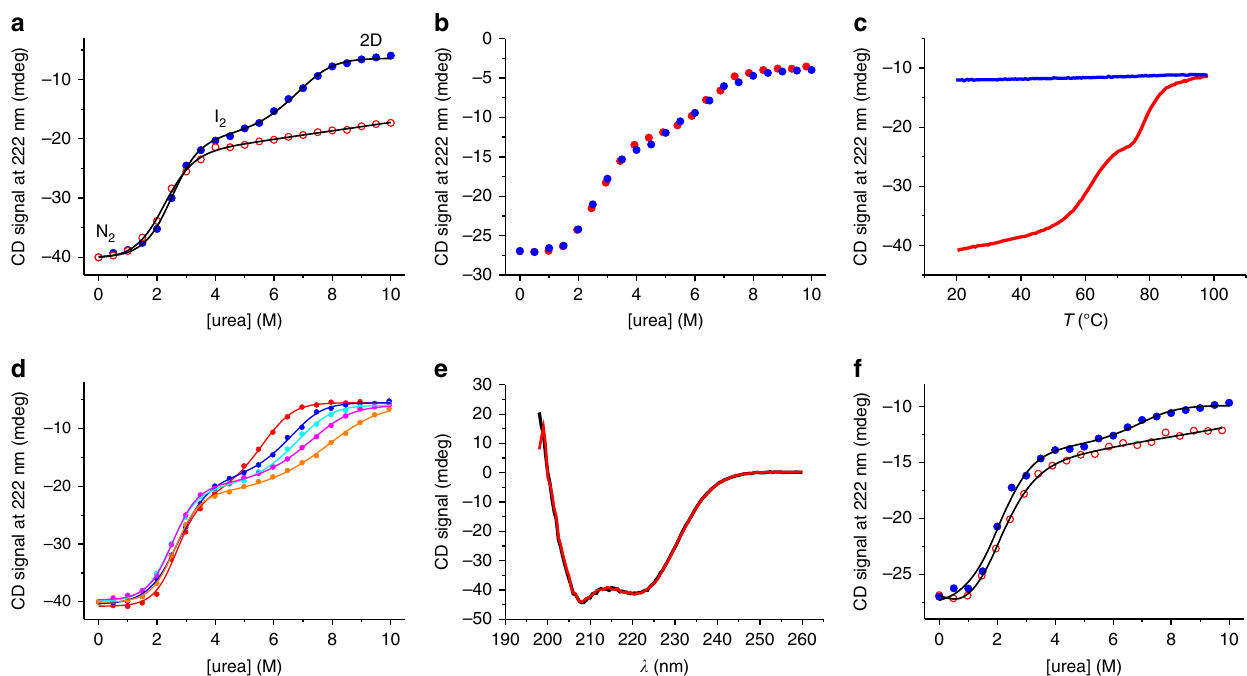
Fig. 1 Equilibrium denaturation measured by far-UV CD spectroscopy. a Equilibrium chemical denaturation of 15 µ M CTD measured under reducing (blue fi lled circles) and under nonreducing (red open circles) conditions at pH 7.0. Black lines are fi ts to the data using a thermodynamic model for a two-state transition (in case of nonreducing conditions) and for a three-state transition involving a dimeric intermediate (in case of reducing conditions). The nature of populated states is indicated. b Renaturation of 10 µ M CTD, denatured in 10 M urea and refolded by dilution into pH 7.0 buffer (blue solid spheres). Corresponding denaturation data are shown for comparison (red solid spheres). c Thermal denaturation of 15 µ M CTD measured under nonreducing conditions at pH 7.0 (red). A refolding trial measured by cooling the thermally denatured sample is shown in blue. d Chemical denaturation of CTD measured under reducing conditions and at varying protein concentration. Data recorded from 5 (red circles), 10 (blue circles), 15 (cyan circles), 20 (magenta circles), and 30 µ M (orange circles) CTD are shown. Data are normalized to the native-state signal of 15 µ M CTD for reasons of clarity. Lines are fi ts to the data using the thermodynamic model for a three-state transition involving a dimeric intermediate. e Far-UV CD spectra of CTD recorded under non-reducing conditions in pH 7.0 (black line) and in pH 5.7 (red line) buffered solutions. f Chemical denaturation of 10 µ M CTD recorded at pH 5.7 under reducing conditions (blue closed circles) and under nonreducing conditions (red open circles). Black lines are fi ts to the data using thermodynamic models for a three-state and for a two-state transition,